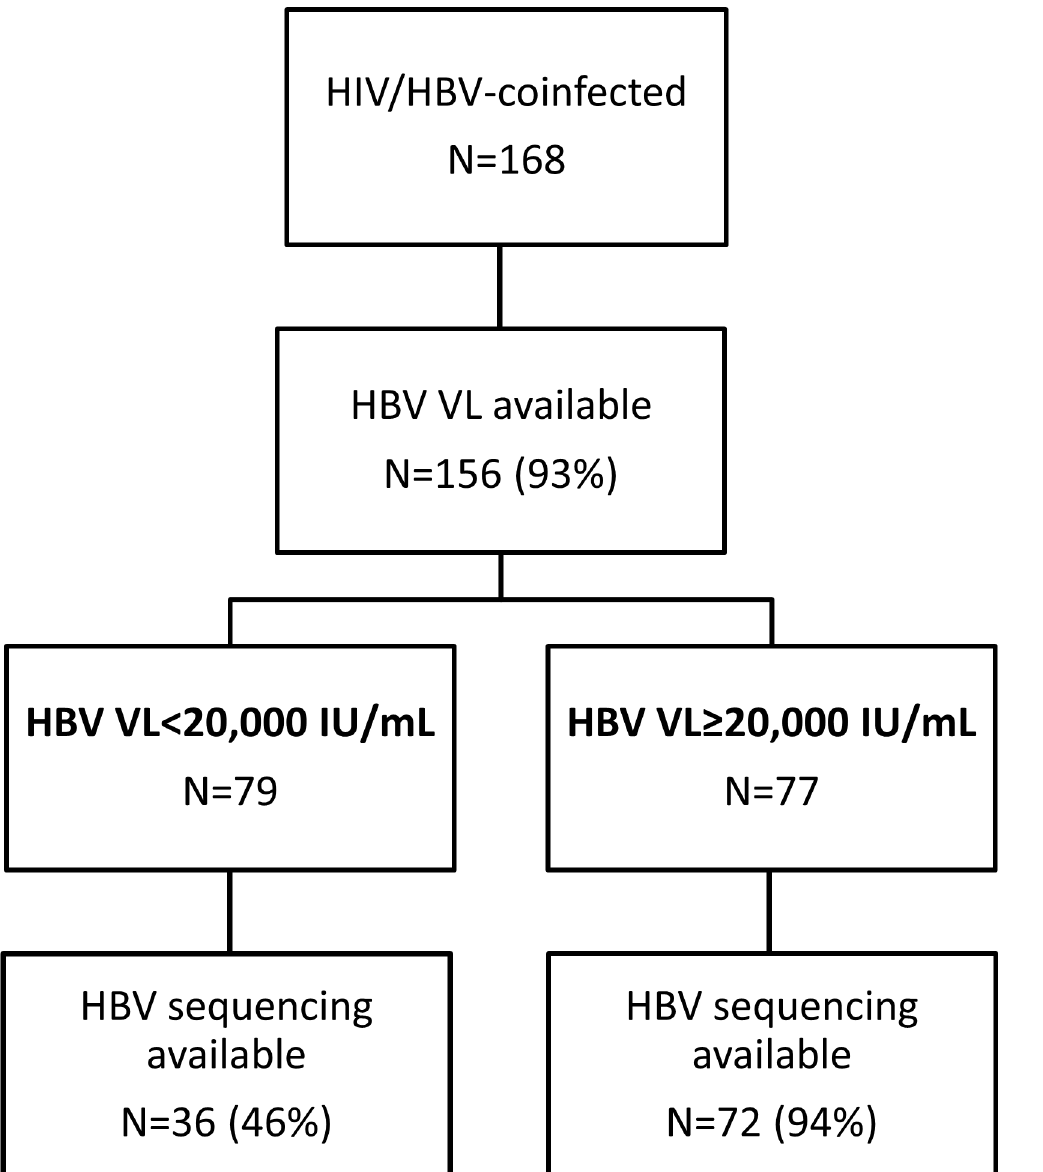
Fig 1. Flow chart of patients included in virological analyses. (HBV: hepatitis B virus; VL: viral load)